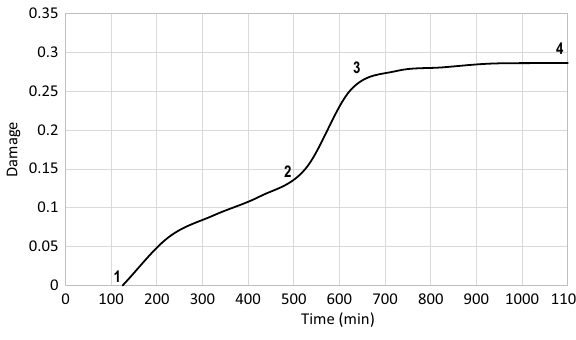
Fig. 13 Evolution of scalar damage variable at the perforation wall